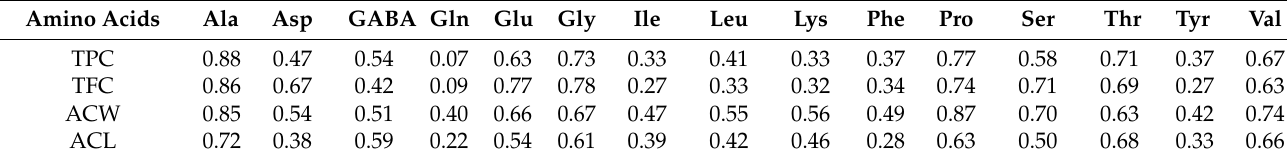
Table 5. Calculated correlations between amino acids and TPC, TFC, ACW, ACL. TPC—total polyphenol content,